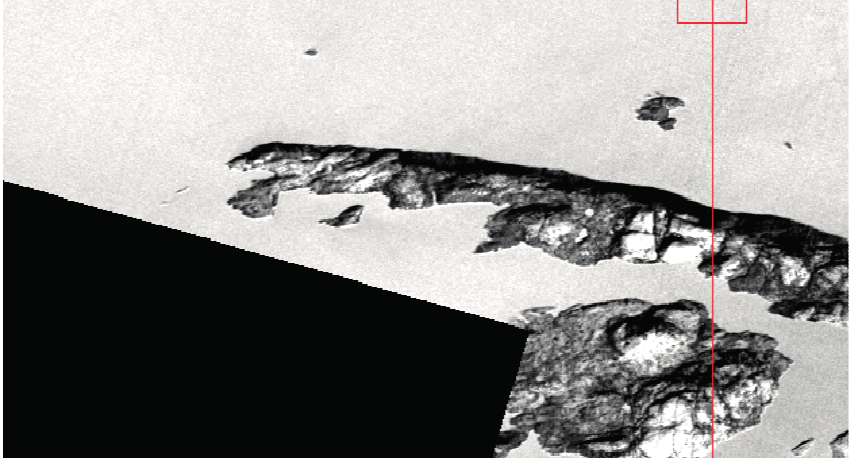
Figure 14. Cirrus band image in Northern Quebec of a frozen reservoir and island. The image was processed such that the FPM edges were not cropped, so the FPM boundary is apparent. The coastline of the island is properly registered across that boundary indicating that the Cirrus band imagery will be aligned when the signal is strong enough to make the crosstalk